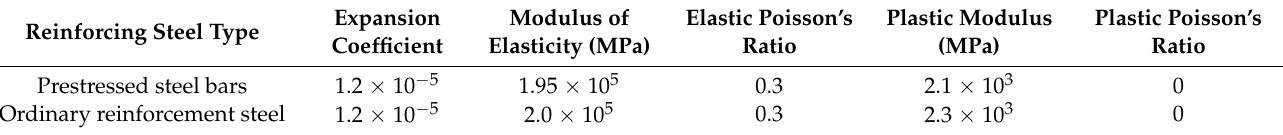
Table 3. Parameters of elasto-plastic model of steel